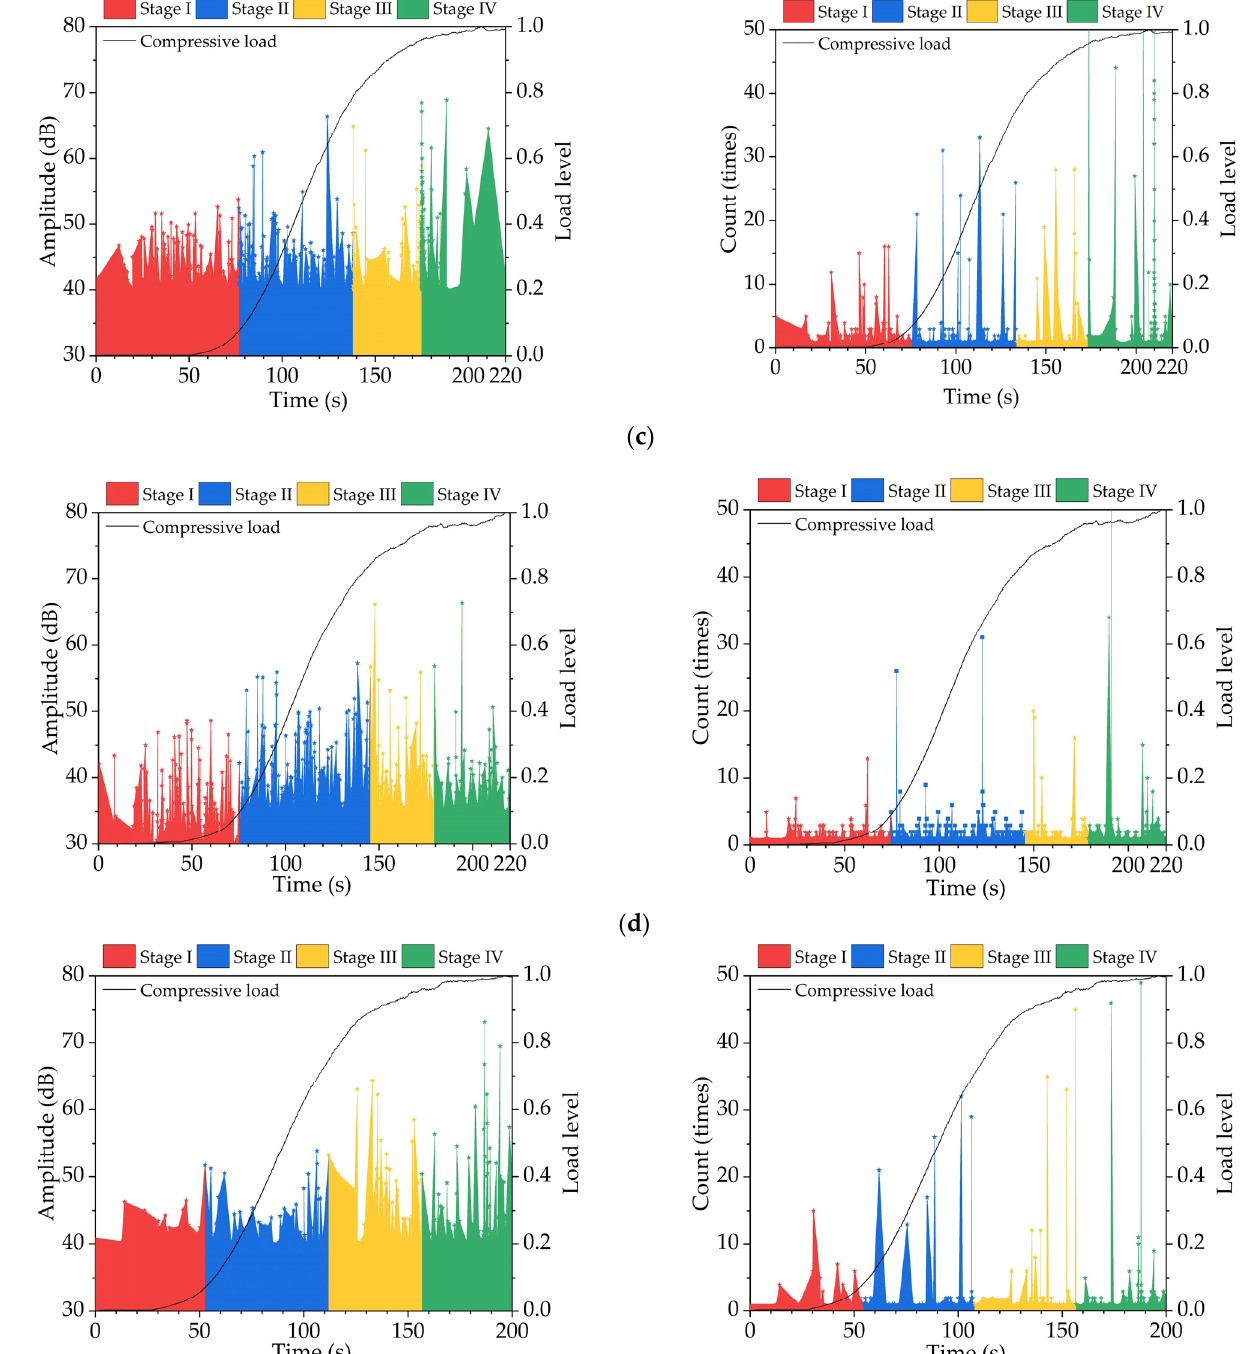
Figure 5. The AE direct parameters (amplitude and count) versus compressive load level for asphalt mixture subjected to F-T condition: ( a ) AE amplitude/count vs. load level under 0 cycle; ( b ) AE amplitude/count vs. load level under 3 cycles; ( c ) AE amplitude/count vs. load level under 9 cycles; ( d ) AE amplitude/count vs. load level under 15 cycles; ( e ) AE amplitude/count vs. load level under 21 cycles.